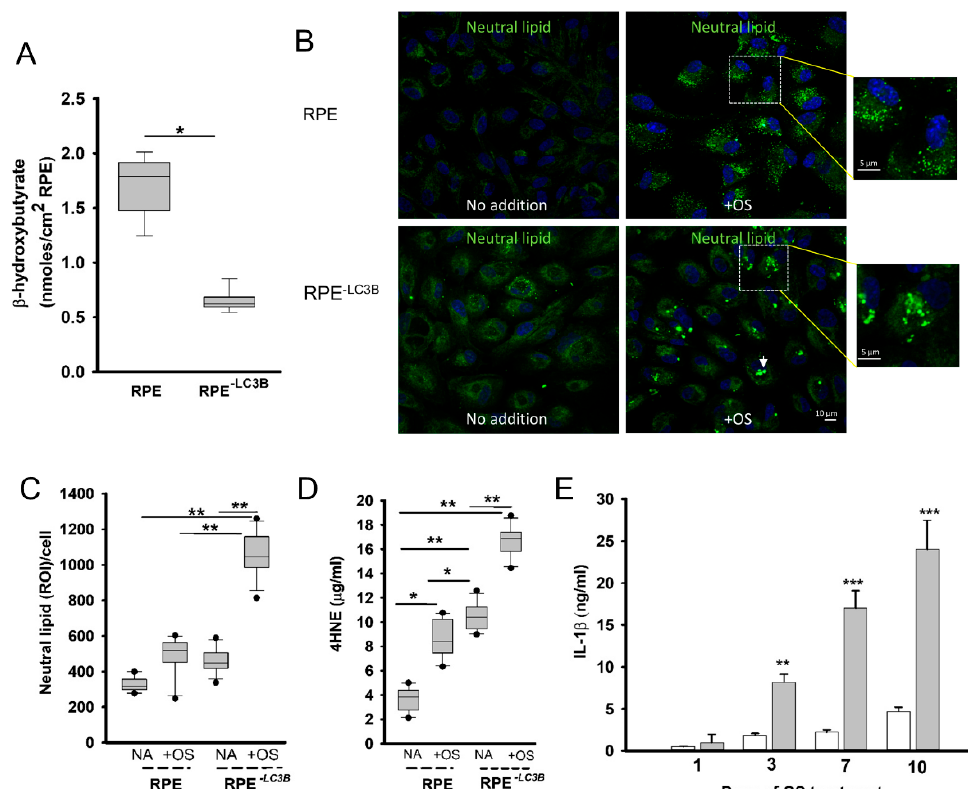
Figure 1. Loss of LC3B-associated OS phagocytosis results in lipid overload, peroxidation and cytokine release ( A – E ). ( A ). RPE or RPE -LC3B cells were incubated in the chamber with OSs and the apical supernatant was evaluated for β HB content after 2 h. The box plots show data for three independent experiments, each done in triplicate. One-way ANOVA was used for comparison across the RPE cells, and post-hoc pairwise comparison using Tukey correction was used. * indicates p < 0.050. ( B ). RPE or RPE -LC3B cells were incubated with OS once daily for 7 days. Representative confocal image of neutral lipid deposits (green) detected by staining with BODIPY493/503 and nuclei (blue) stained with Hoechst 33342. White arrowhead indicates large aggregates on the RPE -LC3B . ( C ). The intensity of BODIPY493/503 staining was quantified and puncta localized as indicated. INSETS: depict the size and general shape of lipid deposits. The box plots show data for three independent experiments, each done in triplicate. One-way ANOVA was used for comparison across the conditions tested, and post-hoc pairwise comparison using Holm–Sidak correction was used. For each independent experiment, we analyzed 5 fields, with each field containing at least 25 cells. ** indicates p < 0.020. ( D ). The level of 4-hydroxynonenol (4-HNE) protein adducts measured by ELISA for RPE or RPE -LC3B cells fed OS in the long-term challenge study. The box plots show data for three independent experiments, each done in triplicate. One-way ANOVA was used for comparison across the conditions tested, and post-hoc pairwise comparison using Holm–Sidak. * indicates p < 0.050 and ** indicates, p < 0.020. ( E ). Levels of IL-1 β released into apical media by ELISA for RPE (white bars) or RPE -LC3B cells (grey bars) challenged with OS in long-term fed study. Each of three samples was tested in triplicate per cell type on each day indicated. Bar plots show mean ± SEM. Data were analyzed using unpaired Student’s t -test with p values as indicated. ** p < 0.002, and *** p < 0.001. p values represent a comparison between RPE (white bar) and RPE -LC3B (gray bar) on the days